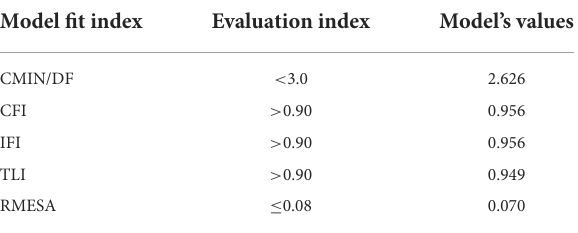
TABLE 6 Discriminant validity analysis.